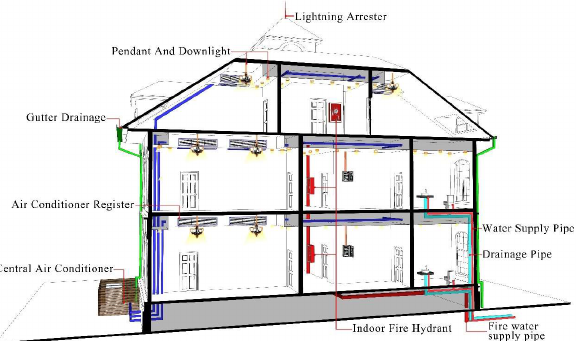
Figure 24. Renewal strategy of construction equipment (source: author).